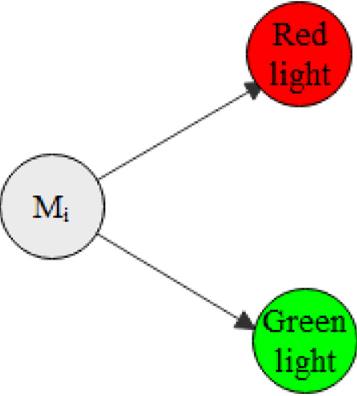
Figure 2. The pattern of